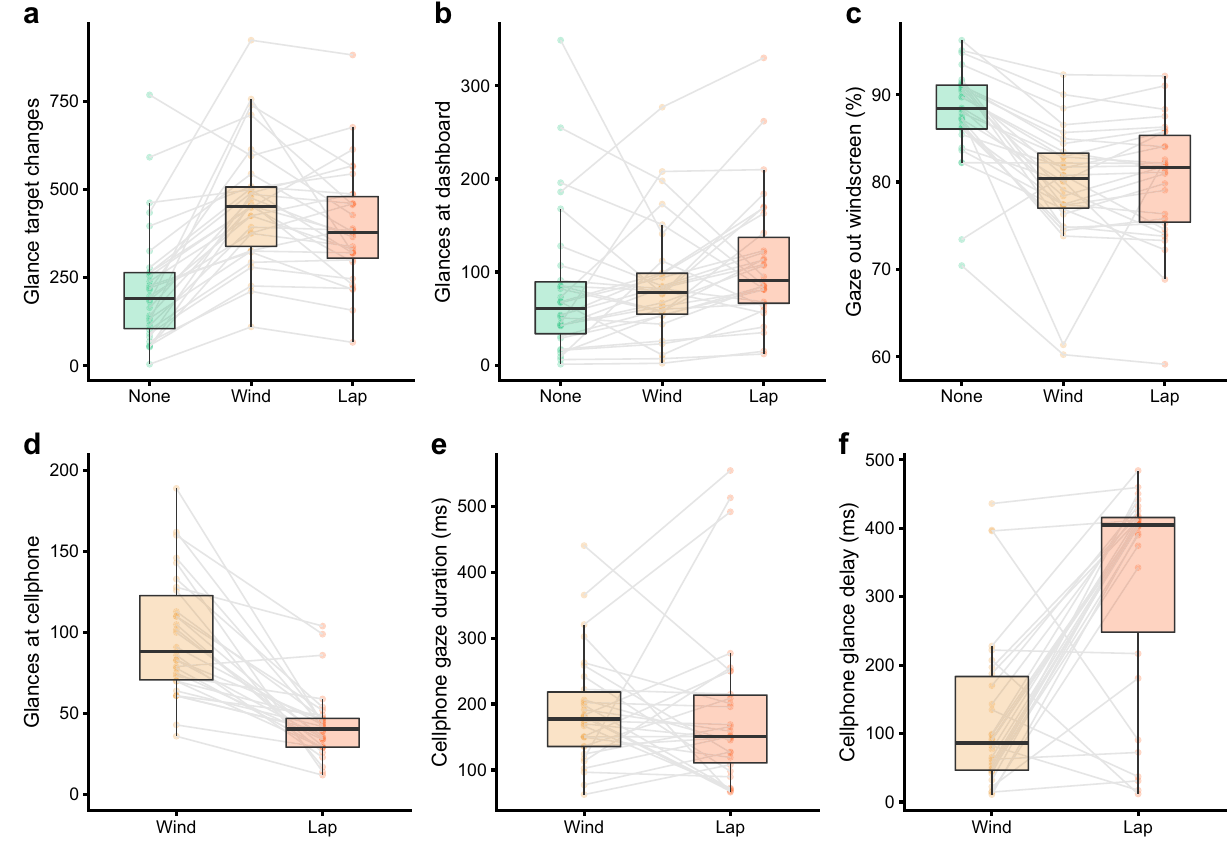
Figure 5. Eyegaze behaviour compared across trials, in terms of the number of glances ( a ) in total, ( b ) at the dashboard, ( c ) forwards out the windscreen, and ( d ) at the cellphone. Subfigure ( e ) shows the mean duration of each gaze at the cellphone, and ( f ) shows the time to first glance at the cellphone after the text message was delivered. The presence of a cellphone changed gaze behaviour, with less time spent looking out the window. Compared to the cellphone on the lap, participants glanced more frequently at the cellphone on the windscreen but did so for a similar total duration. However, when the cellphone was at lap height, participants delayed their glance at the cellphone after receiving the incoming text message compared to when the phone was on the